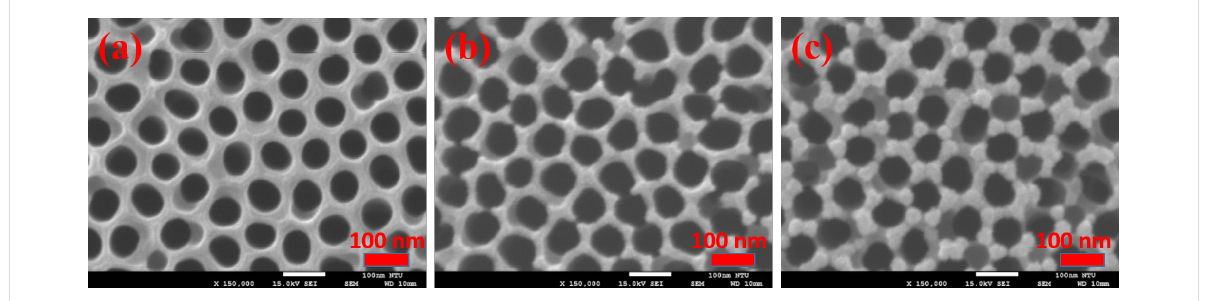
Figure 1: Scanning electron microscopy images of the anodic aluminum oxide (AAO) nanostructure on a sapphire substrate: sample (a) AAO60, (b) AAO70, and (c) AAO80.